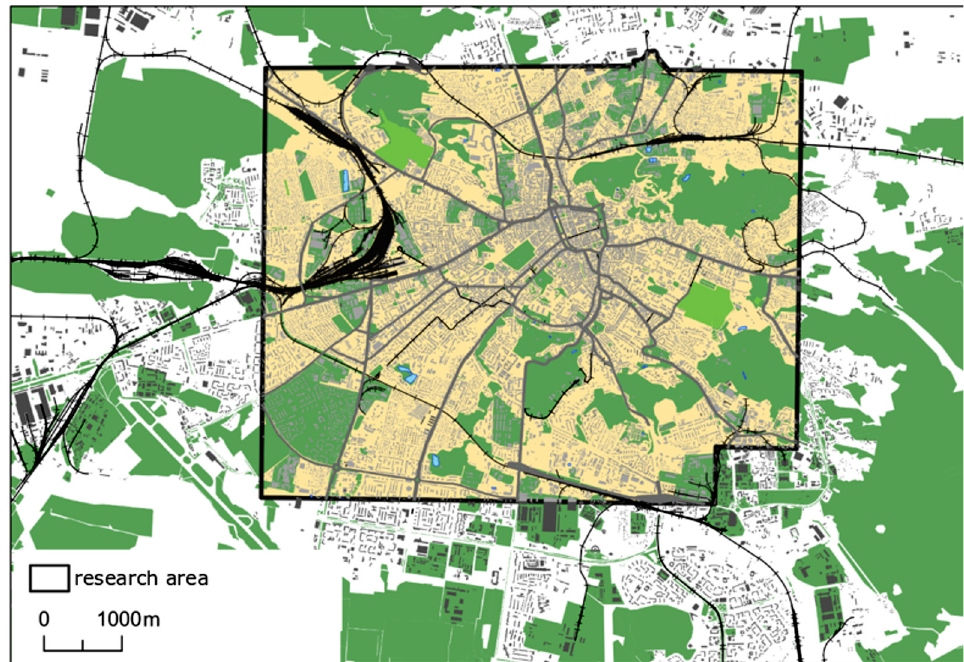
Fig. 1. The range of research (own work based on OpenStreetMap vector